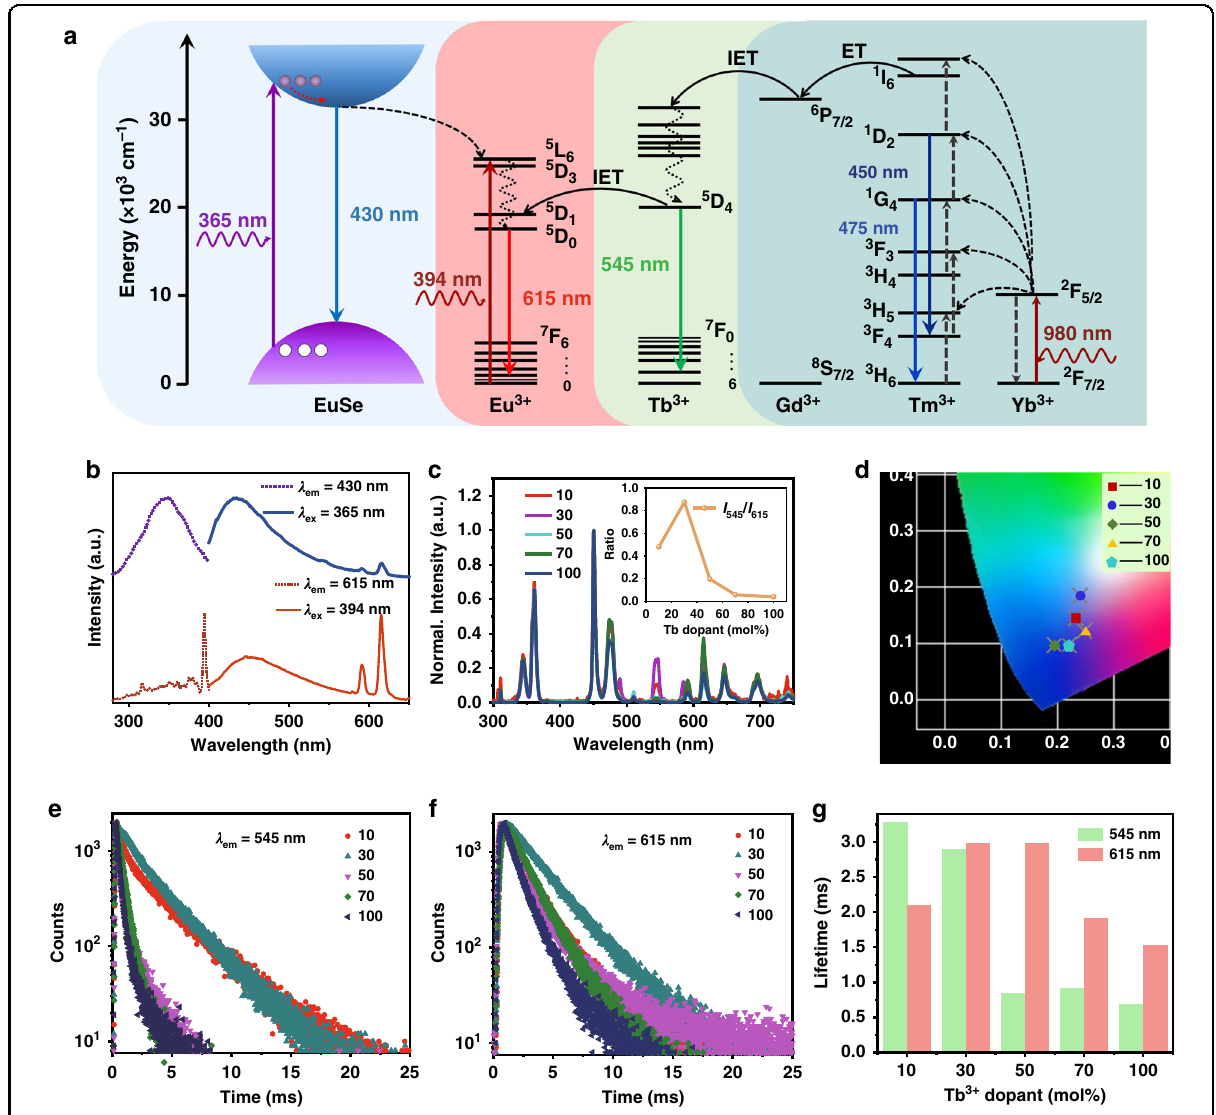
Fig. 2 Optical investigations of NaGdF 4 :Yb,Tm@NaYF 4 :x%Tb@EuSe (denoted as LNP:x%Tb@EuSe) nanocomposites. a The energy transfer mechanism of LNP:x%Tb@EuSe nanocomposites for down-shifting luminescence under UV irradiation (365 and 394 nm, respectively) and upconversion emission under 980 nm laser irradiation. b Normalized excitation (blue dotted line, λ em = 430 nm; and red dotted line, λ em = 615 nm) and emission (blue solid line, λ ex = 365 nm; and red solid line, λ ex = 394 nm) spectra of LNP:50%Tb@EuSe. c Normalized upconversion emission spectra of LNP:x%Tb@EuSe (x = 10, 30, 50, 70, and 100) under 980 nm laser excitation (10 W cm -2 ). Inset shows the ratio of emission intensity at 545 nm ( 5 D 4 → 7 F 5 electronic transition of Tb 3 + ) and 615 nm ( 5 D 0 → 7 F 2 electronic transition of Eu 3 + ) with different concentrations of Tb 3 + ions. d The CIE chromaticity diagram of LNP:x%Tb@EuSe (x = 10, 30, 50, 70, and 100) under 980 nm laser irradiation. Concentration dependent luminescence decay curves of ( e ) Tb 3 + at 5 D 4 state (monitored at 545 nm) and ( f ) Eu 3 + at 5 D 0 state (monitored at 615 nm) in the LNP:x%Tb@EuSe ( x = 10, 30, 50, 70, and 100) under 980 nm pulsed laser excitation. g The luminescence average lifetime values of Tb 3 + 5 D 4 state at 540 nm (green bars) and Eu 3 + 5 D 0 state at 615 nm (orange bars) based on Fig. 2e, f,